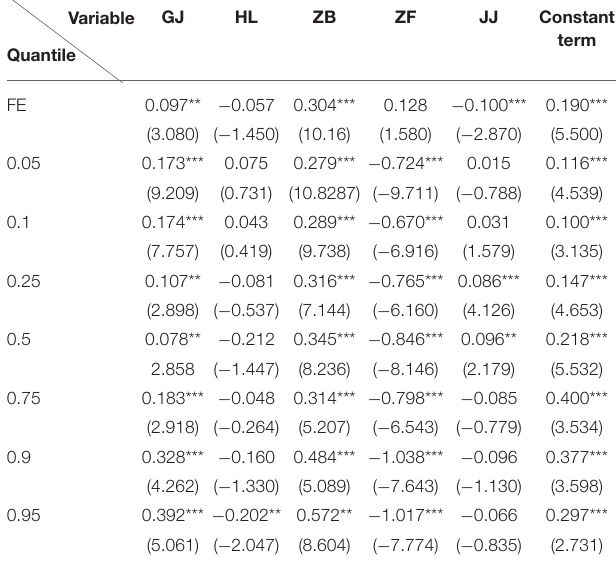
TABLE 4 | Statistical description of main variables. Variable Observations